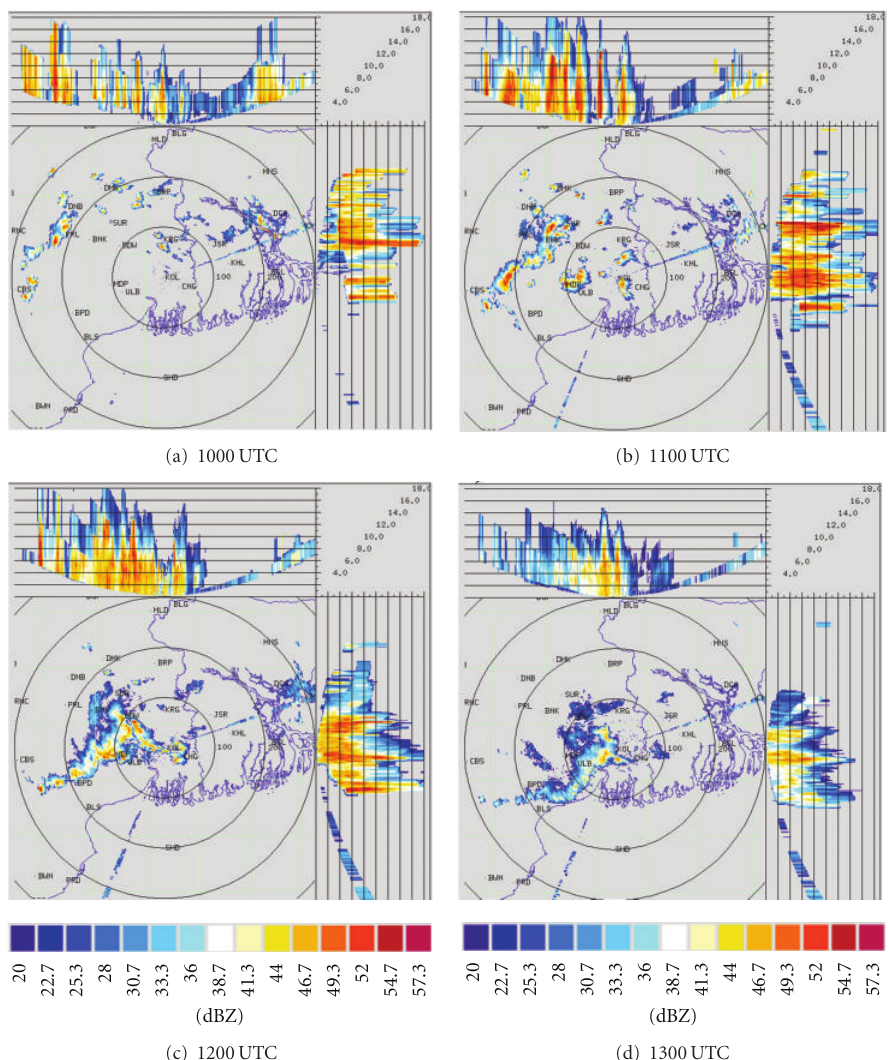
Figure 10: Kolkata DWR composite radar reflectivity (dBZ) imageries from 1000 to 1300 UTC on 15, May,